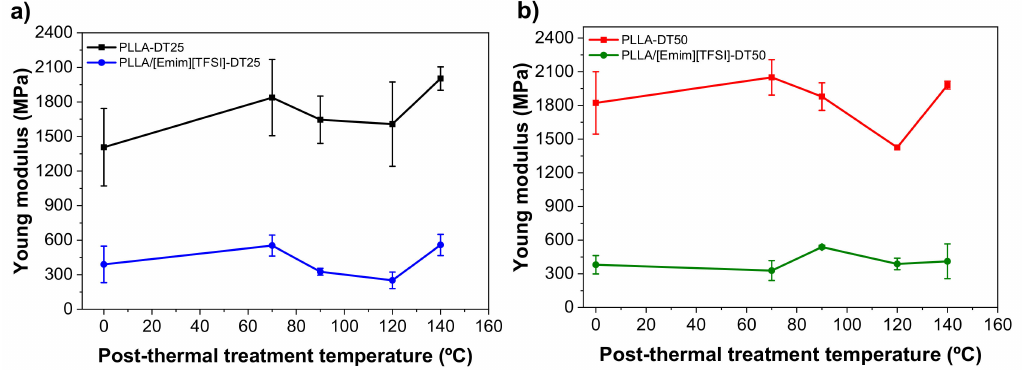
Figure 7. Young modulus as a function of the post-thermal treatment temperature for PLLA and PLLA / [Emim][TFSI] films dried at: ( a ) 25 ◦ C and ( b ) 50 ◦ C.